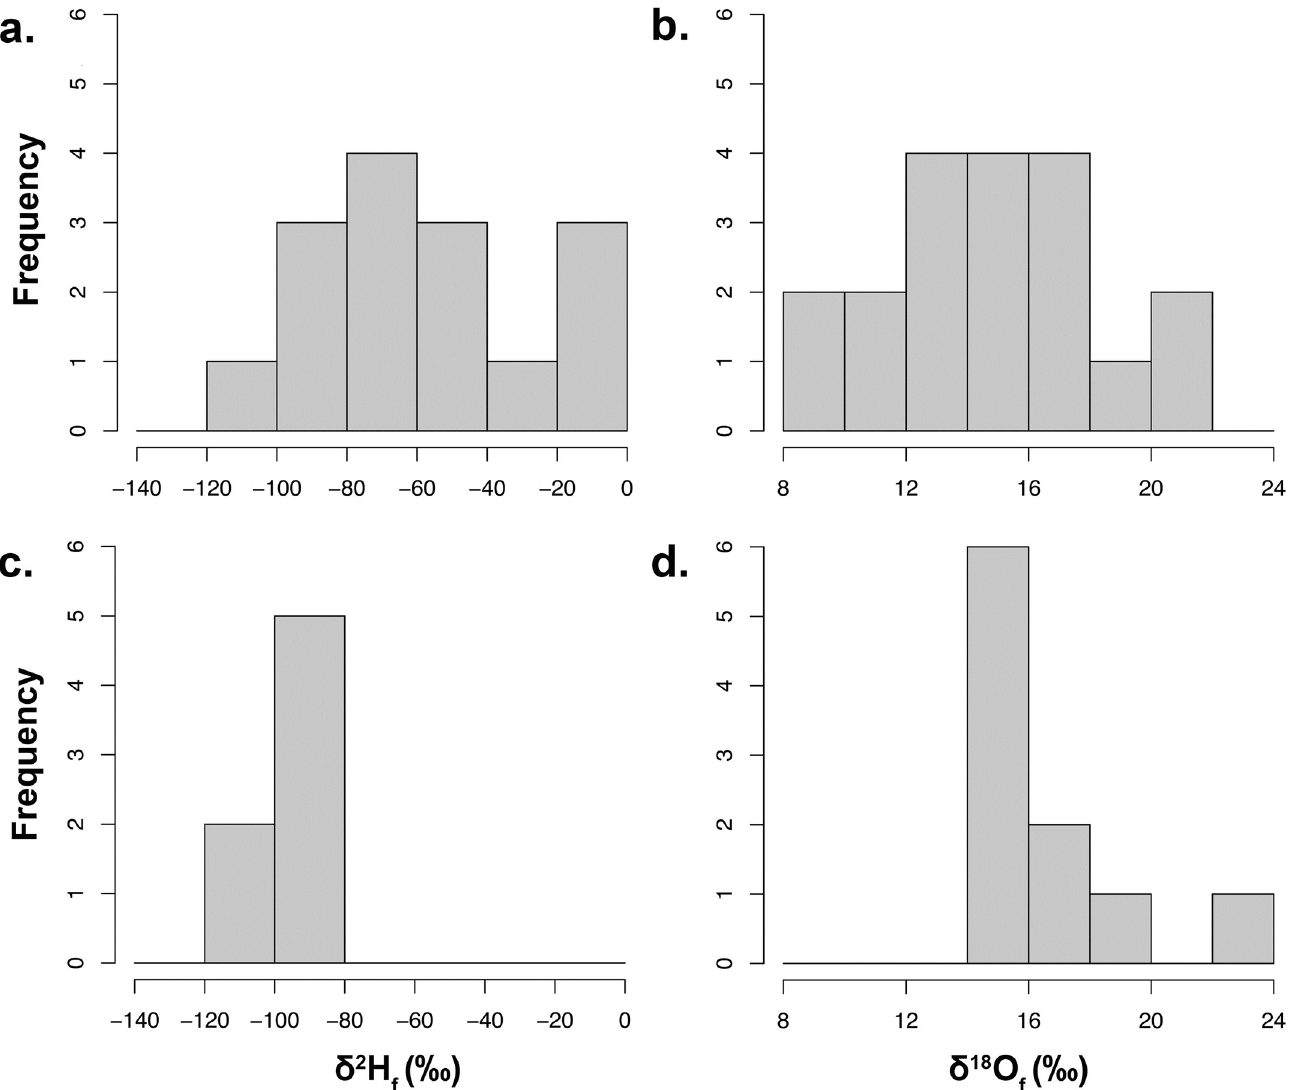
Fig 5. Frequency distribution of the isotope compositions of feathers of migratory Sharp-shinned Hawks. Predicted stable hydrogen ( δ 2 H F ‰) and oxygen ( δ 18 O F ‰) isotopic compositions of precipitation at the natal origin for migratory Sharp-shinned Hawk ( Accipiter striatus ) specimens collected (a and b) along the Pacific Coast Flyway at the Golden Gate Raptor Observatory (GGRO, n = 17), and (c and d) along the Intermountain Flyway at the Goshute Mountains HawkWatch (Goshutes, n = 10). Values on the y-axis represent counts of individual specimens.